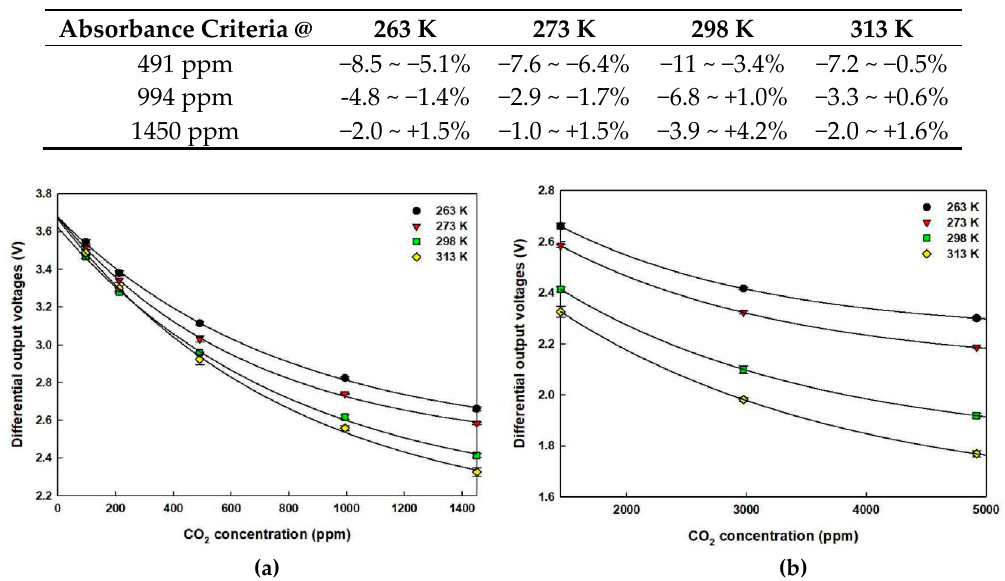
Table 1. Estimation errors of CO 2 concentrations as a function of ambient temperatures according to the criteria of IR absorbance.